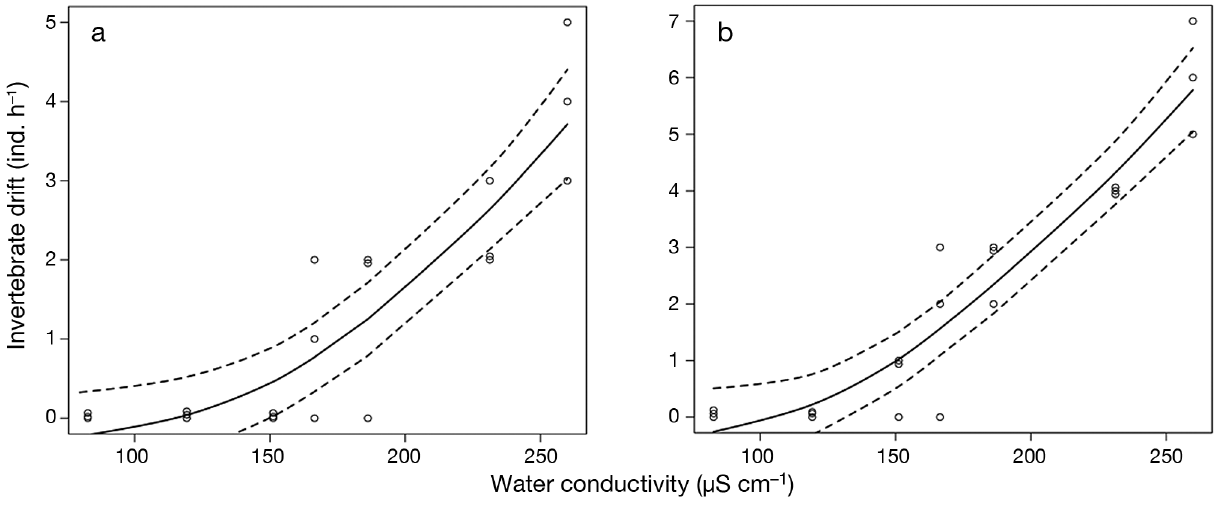
Fig. 3. Adjusted model correlating drift rates (ind. h−1) and conductivity (µS cm−1). Dashed lines are 95% confidence intervals. (a) Andesiops peruvianus ; (b) Smicridea